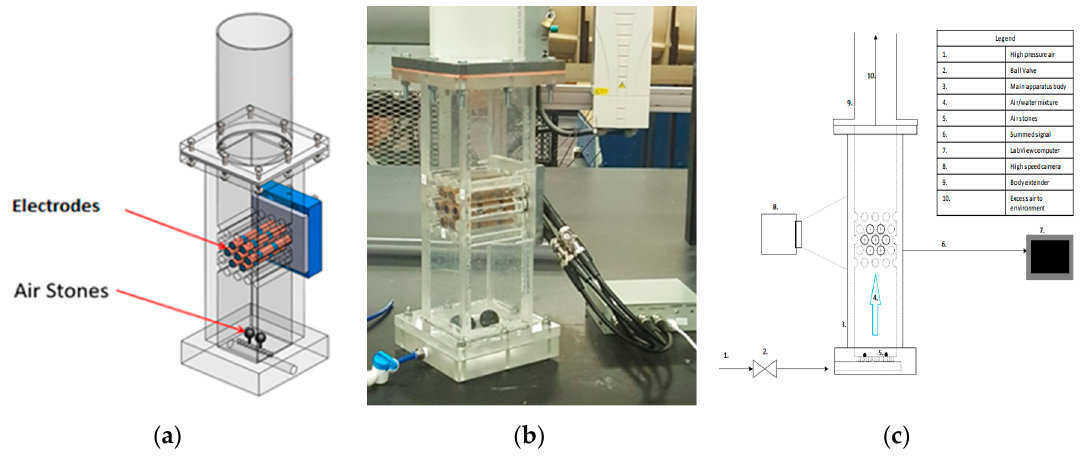
Figure 4. ( a ) Three-dimensional (3D) model of the apparatus; ( b ) actual picture of apparatus used for the experiment; ( c ) flow diagram.